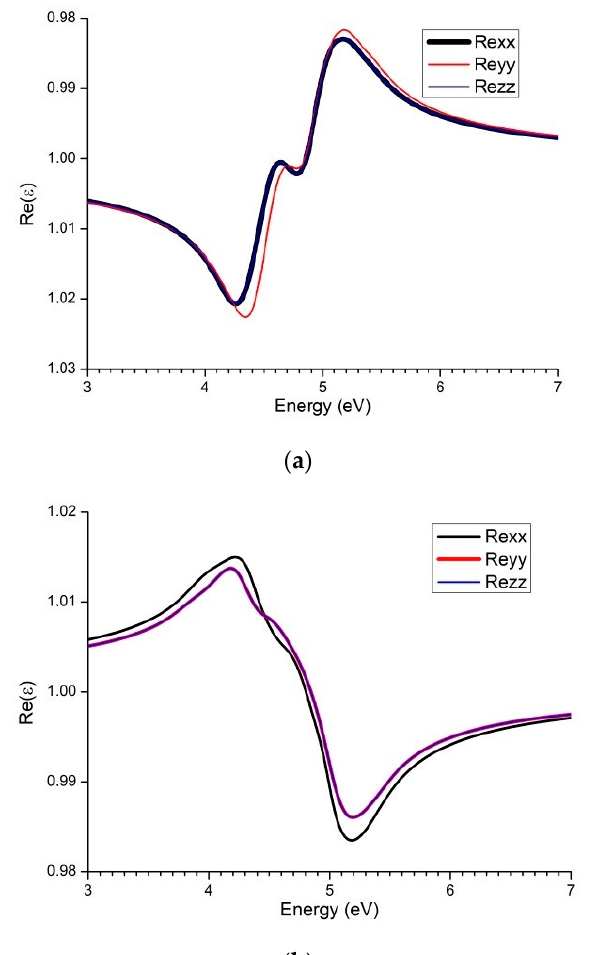
Figure 7. The real part of dielectric function in YAG doped by La ( a ) with 2 atoms ( b ) with 4 at- oms.